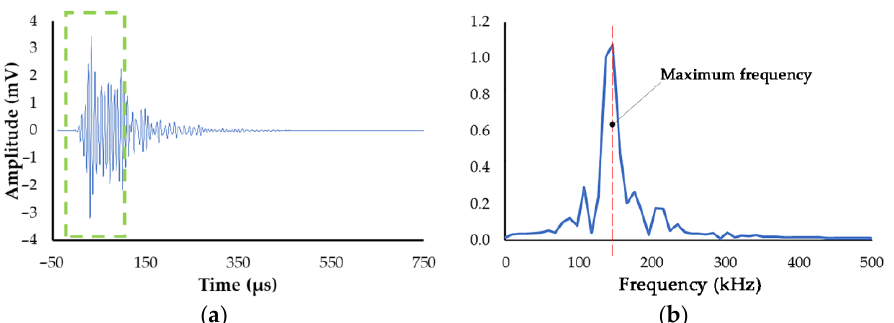
Figure 16. Acoustic emission signal recorded in the laboratory test. ( a ) transient signal; ( b ) frequency spectrum calculated in the time window indicated as a green box.